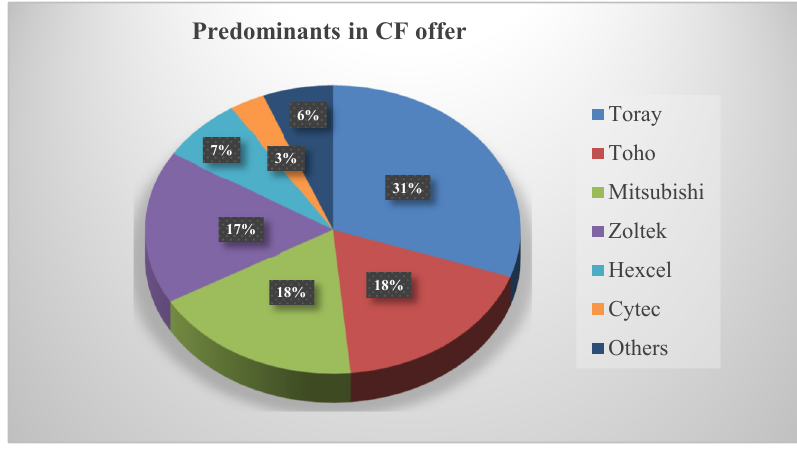
Figure 6. CF manufacturers worldwide.